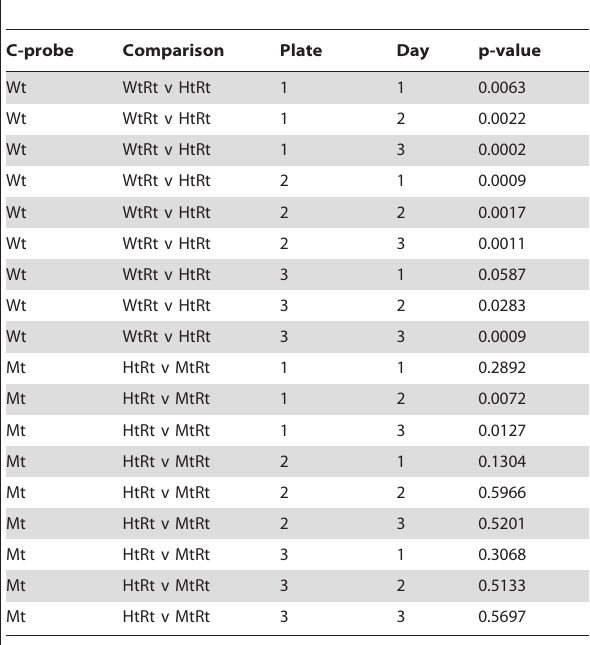
Table 5. Within plate comparison of Rts between C-probe- homozygote and